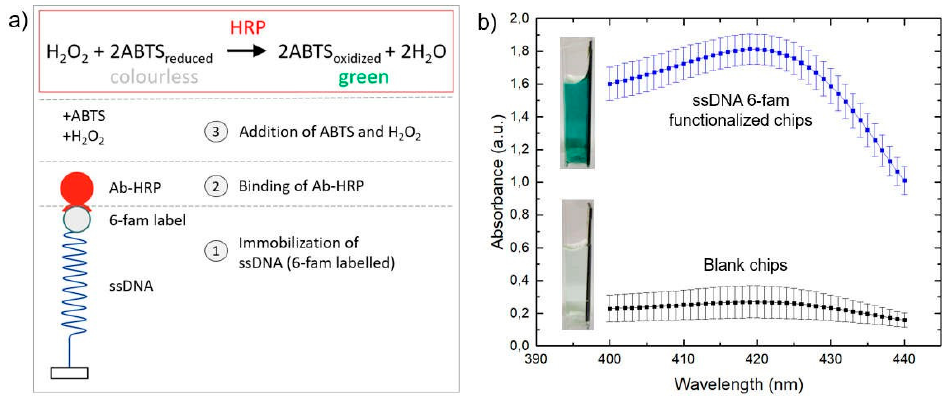
Figure 4. ( a ) On-chip ELISA assay. Step 1: ssDNA immobilization onto the chip surface, Step 2: Ab- HRP binding to the 6-fam label, Step 3: ABTS and H 2 O 2 are added inducing a reaction transforming ABTS to its oxidized green form, ( b ) Absorbance spectra of blank and ssDNA functionalized